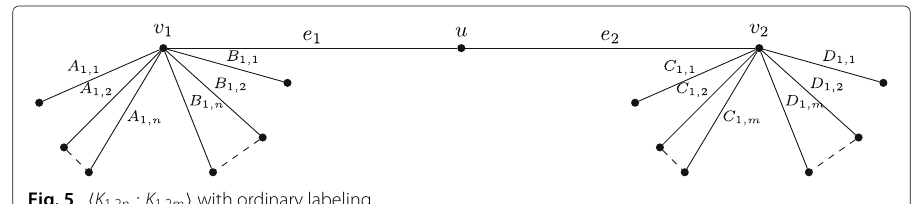
Fig. 5 (cid:2) K 1,2 n : K 1,2 m (cid:3) with ordinary labeling